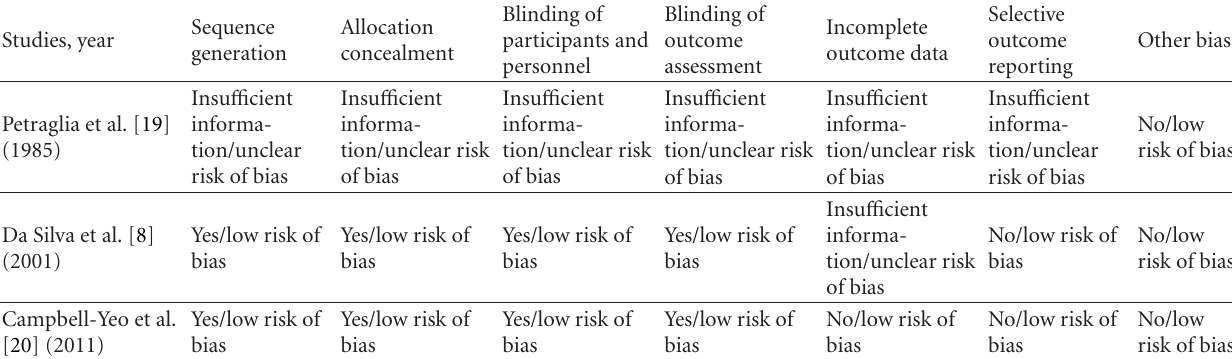
Table 2: Methodological quality of RCTs included in the